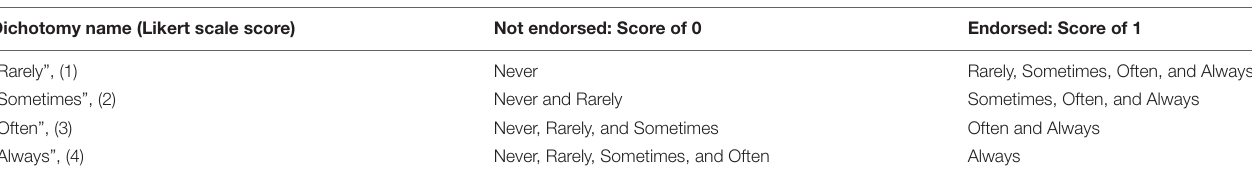
TABLE 3 | Endorsement criteria for the